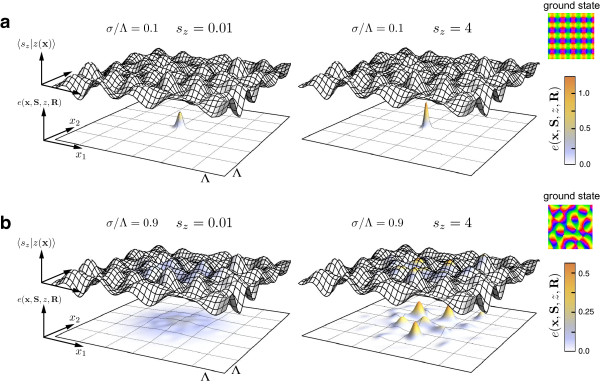
Different patterns of evoked activity for different effective ranges of intracortical interaction in the EN model. The component 〈sz|z(x)〉 of the orientation map z(x) in the direction of the stimulus sz is plotted as a meshed 3D graph in a 6Λ × 6Λ patch. Color code and height of the projection below indicate the strength of activation. The stimulus is presented in the center of the displayed cortical subregion. (a) Evoked activity patterns e(x, S, z, r) for small interaction range σ/Λ = 0.1 and weakly oriented stimulus with sz = 0.01 (left) and strongly oriented stimulus with sz = 4 (right). rPWCs (see upper right) are optimal in this regime. (b) Evoked activity patterns e(x, S, z, r) for large interaction range σ/Λ = 0.9 and weakly oriented stimulus with sz = 0.01 (left) and strongly oriented stimulus with sz = 4 (right). Spatially aperiodic 8-planforms (see upper right) are optimal in this regime. A uniform retinotopy was assumed in all cases for simplicity.